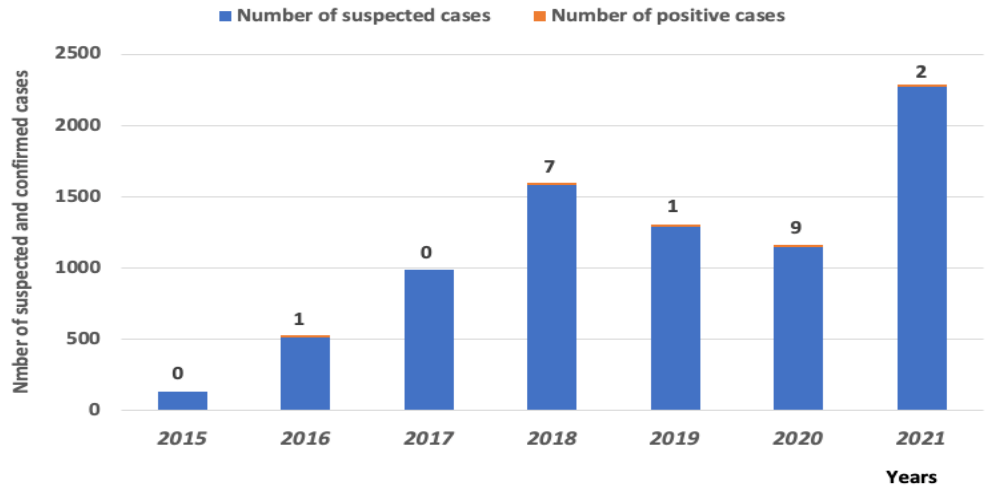
Figure 2. Geographical distribution of human and mosquito cases of WNV in Senegal from 2016 to 2021. Red dots show regions where WNV positive human cases were isolated and blue dots where WNV positive mosquitoes were isolated. Human cases are found according to this map mainly in the north, the west and the south east of Senegal, and mosquito cases mainly in the north.